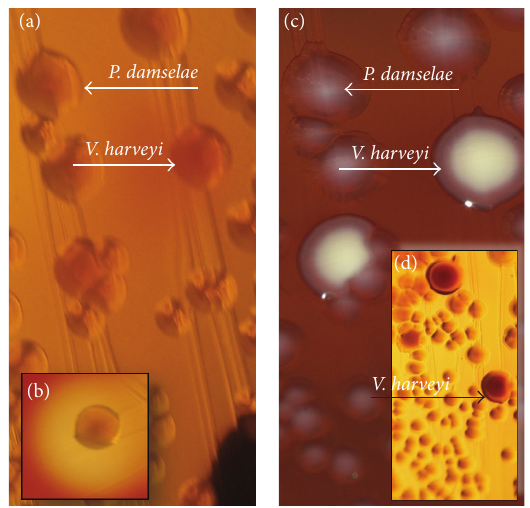
Figure1:Growthof P.damselae and V.harveyi onColumbiaagar,(a) following 24 and (c) following approximately 48hrs of incubation, as observed from the original inoculation. The colony marked with V. harveyi in (c) has a diameter of 2-3mm. Note that (a), (b), and (d) were taken with flash against transmitting sunlight while (c) was taken with flashlight from above only. The section in (a) shows the growth after 24hrs at 35 ± 1 ∘ C, and (b) is taken at the same time, but illustrating the hemolysis of P. damselae . (c) was taken following additional 24 hrs of incubation, however, at room temperature. While the images (a) and (c) show almost identical sections of the agar plates, they are not superimposable due to variations in the position. (d) illustrates the differences in color, seen especiallyafterapproximately48 hrs,when V.harveyi wasallowedto grow at a more ambient temperature (i.e., room